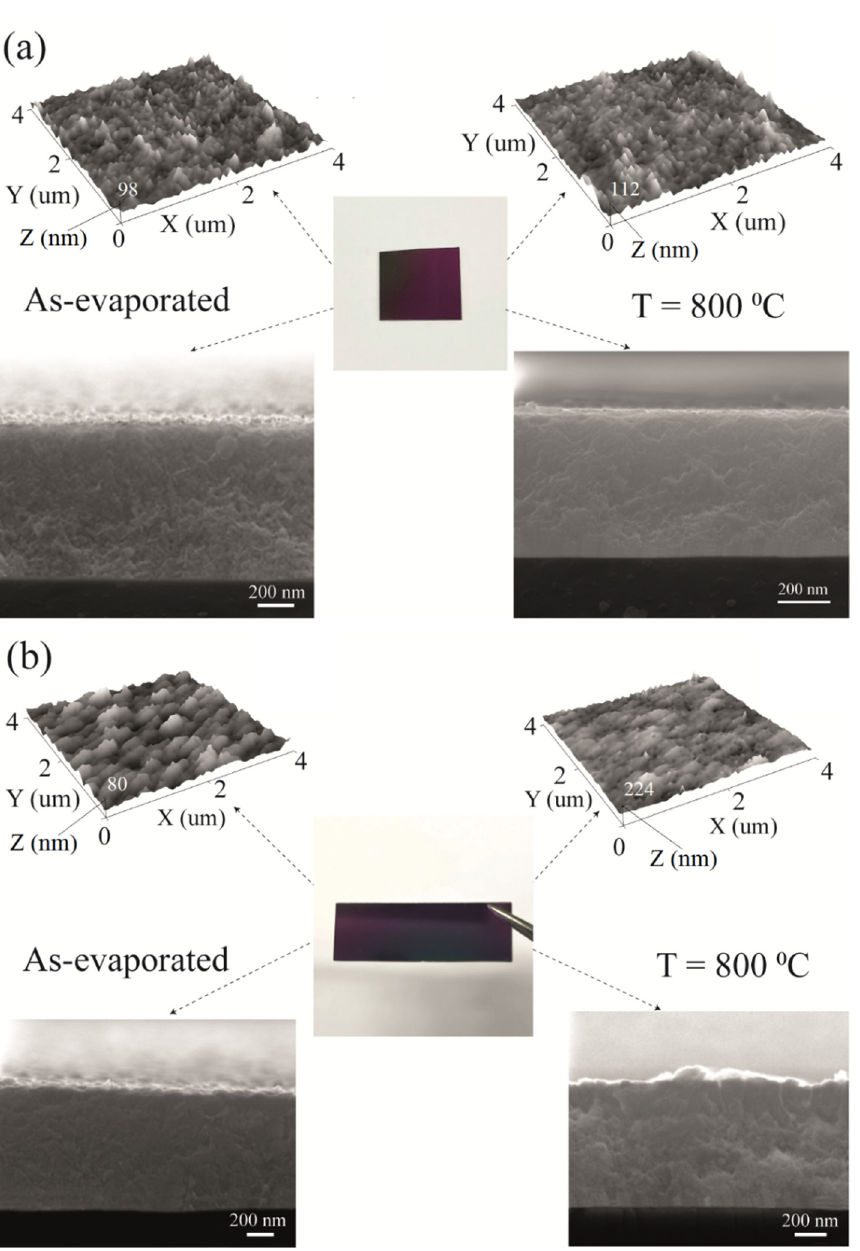
Figure 6. Photo, SEM cross-section view, and 3D AFM images of ( a ) 10-GDC and ( b ) 15-GDC thin films: as-evaporated (left) and annealed at 800 °C (right).